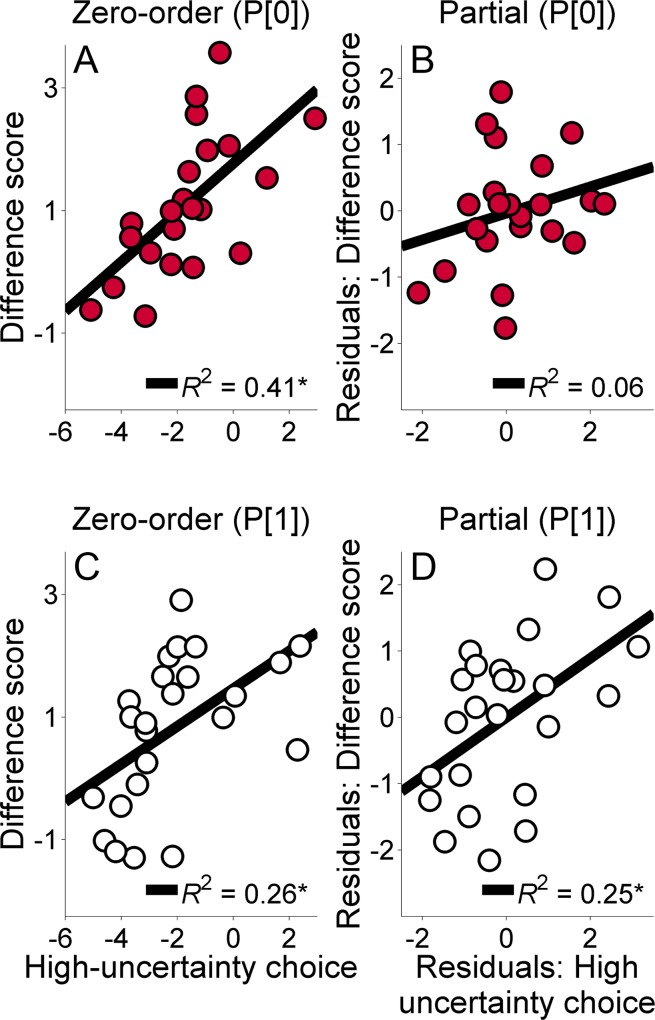
A: Zero-order correlation between the mean log odds of high-uncertainty choices across probabilities of the P[0] condition (abscissa) and the difference score in the log odds of high-uncertainty choices following high-uncertainty-zero (H-Z) outcomes relative to high-uncertainty-small (H-S) outcomes (ordinate).Here, post H-Z high-uncertainty choice behavior was subtracted from post H-S high-uncertainty choice behavior. B: Partial correlation between the two variables in Panel A, controlling for mean post H-Z choice behavior. The abscissa and ordinate show the residuals derived from the correlations of these variables with mean post H-Z choice behavior. C: Zero-order correlation between the mean log odds of high-uncertainty choices across probabilities of the p[1] condition (abscissa) and the difference score in the log odds of high-uncertainty choices following H-S outcomes relative to H-Z outcomes (ordinate). Here, post H-S high-uncertainty choice behavior was subtracted from post H-Z high-uncertainty choice behavior. D: Partial correlation between these two variables, controlling for mean post H-S choice behavior. The abscissa and ordinate show the residuals derived from the correlations of these variables with mean post H-S choice behavior. The best fitting regression line and variance accounted for (R2) is shown in each panel.